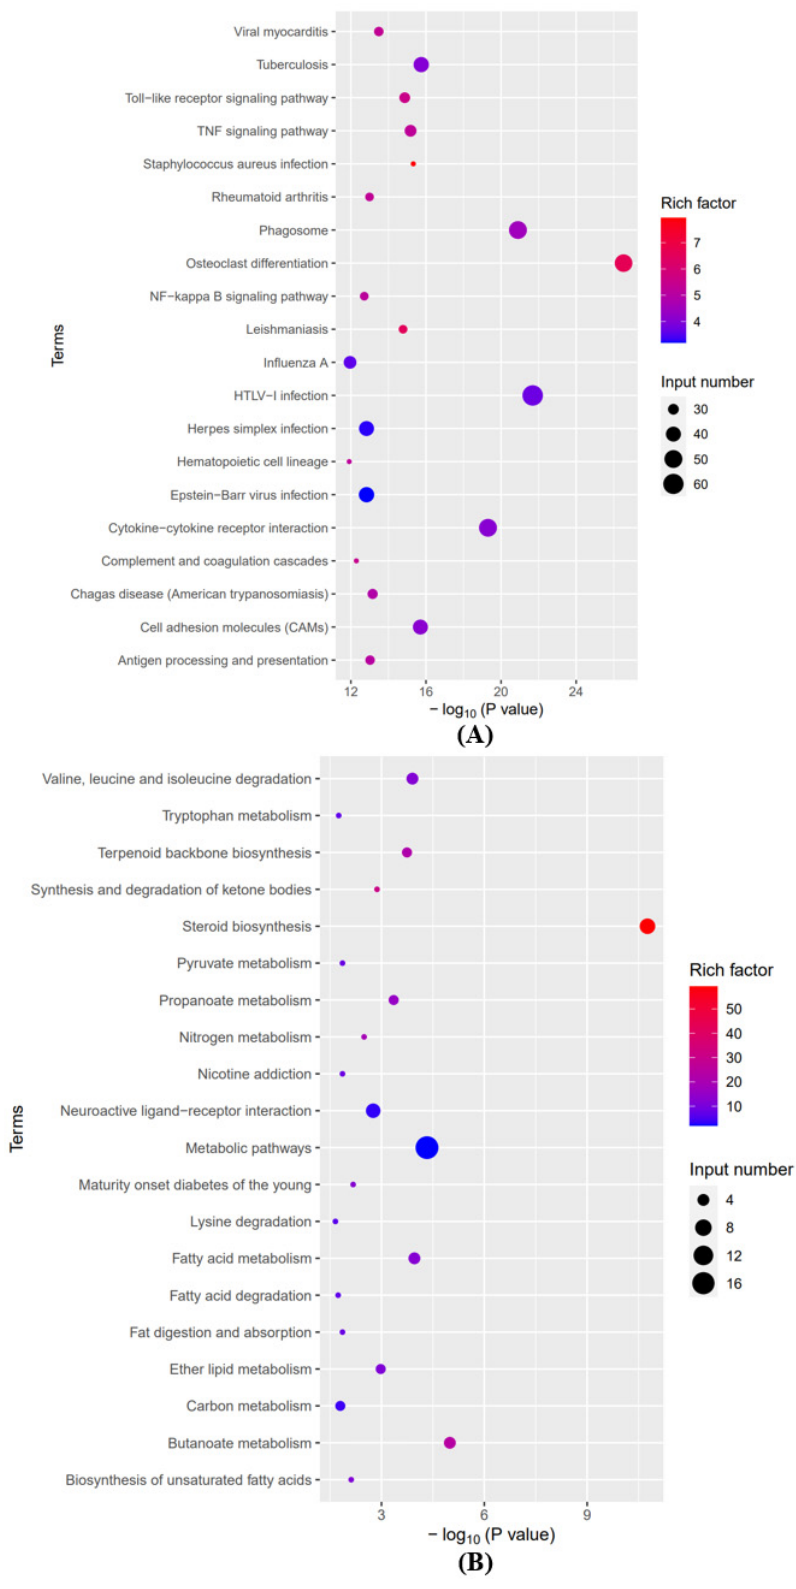
Figure 5. ( A ) The top 20 pathways associated with the up-regulated mRNAs through KEGG pathway analysis. ( B ) The top 20 pathways associated with the down-regulated mRNAs through KEGG pathway